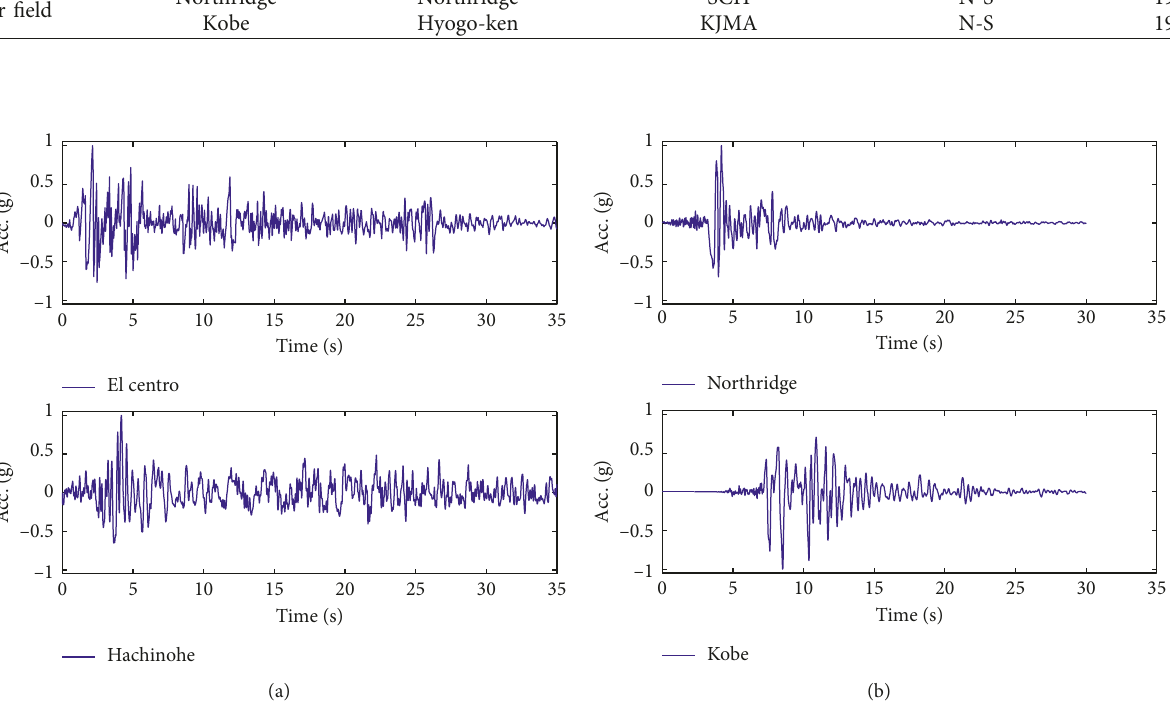
Figure 12: Acceleration-time histories of the earthquakes: (a) far field; (b) near field.